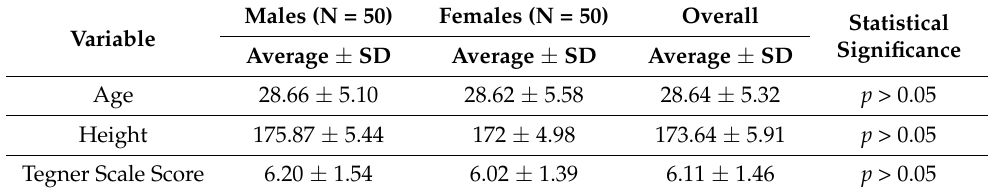
Table 2. Descriptive characteristics of the participants: age, height, and Tegner scale scores. SD, standard deviation; N = 100. Males (N = 50) Females (N = 50) Overall Statistical Variable SignificanceAverage ± SD Height Tegner Scale Score